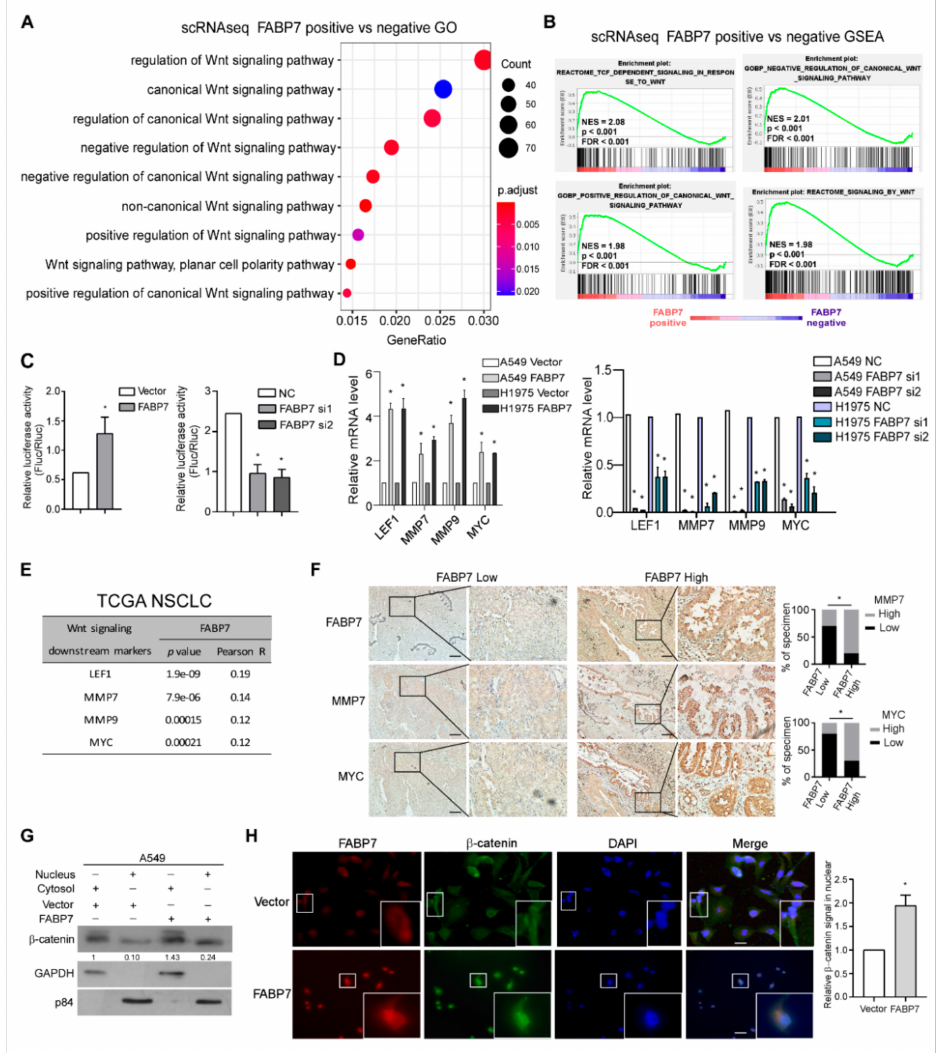
Figure 3. FABP7 transactivates Wnt/ β -catenin signaling. ( A ) Wnt signaling pathway enriched by GO analysis. DEGs from scRNA-seq comparing between FABP7-positive and FABP7-negative tumor cells were analyzed. ( B ) GSEA for Wnt signaling pathway related gene sets from the scRNA-seq dataset, grouped by the FABP7 expression. ( C ) Relative luciferase assay examines effects on Wnt/ β -catenin activation by over-expression (left) or silencing (right) of FABP7. Error bars represent the mean ± SD derived from three independent experiments. Statistical analyses were performed by two-sided Mann-Whitney test, *: p < 0.05. ( D ) Relative mRNA levels of Wnt/ β -catenin downstream targets in FABP7 overexpressing (left) or silencing cells (right). Error bars represent the mean ± SD derived from three independent experiments. Statistical analyses were performed by two-sided Mann-Whitney test (*: p < 0.05). ( E ) Expression correlations between FABP7 and Wnt/ β -catenin signaling targets in NSCLC cohort from TCGA dataset. ( F ) Representative images of immunohistochemistry consecutive slices staining (insets: high-magnification images) showing protein levels of FABP7 and Wnt/ β - catenin signaling target genes in primary NSCLC tumors with low ( n = 10) or high ( n = 10) FABP7 expressions. Scale bar: 50 µ m. Chi-square tests, *: p < 0.05. ( G ) Nucleo-plasma separation and western blotting assays show the changes of β -catenin expression at subcellular level by FABP7 ectopic expression in A549 cells. Representative images from three independent experiments are shown. ( H ) Representative IF images of three independent experiments (insets: high-magnification images) and quantitative results of alterations in β -catenin subcellular localization by FABP7 overexpression in A549 cells. Scale bar: 10 µ m. Error bars represent the means ± SD derived from three independent experiments. Statistical analyses were performed by two-sided Mann-Whitney test (*: p <